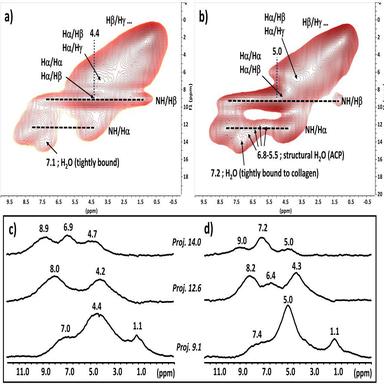
2D 1H DQ-MAS NMR spectrum (νr = 60 kHz) of (a,c) Dm-dentin and (b,d) Hu-dentin with f1 projections at 9.1, 12.6 and 14.0 ppm.